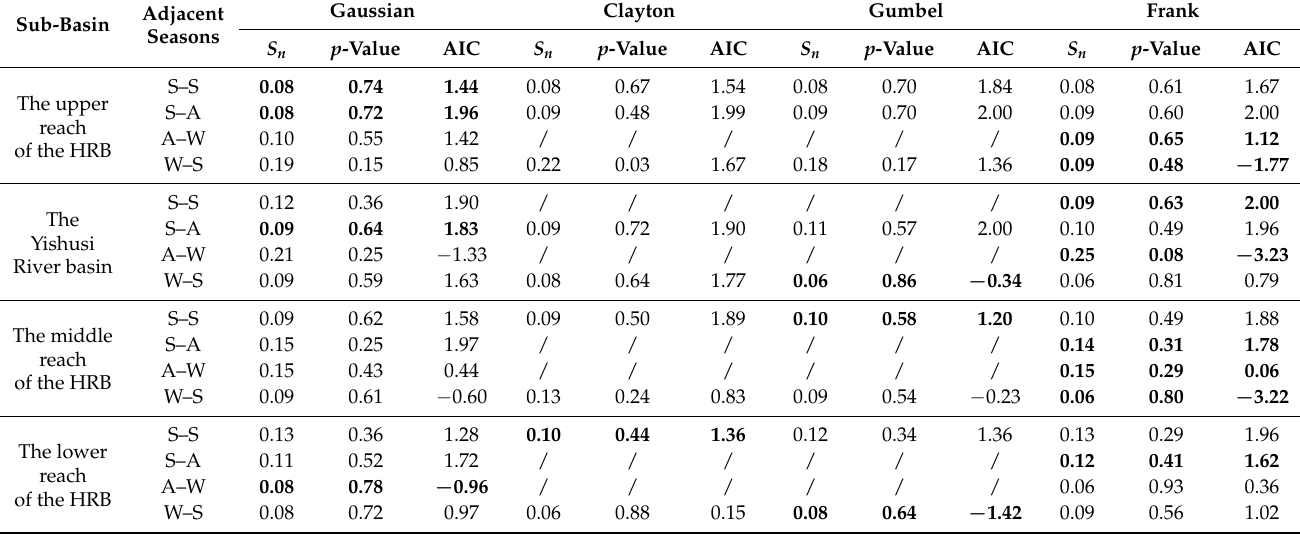
Table 6. The goodness-of-fit of four candidate